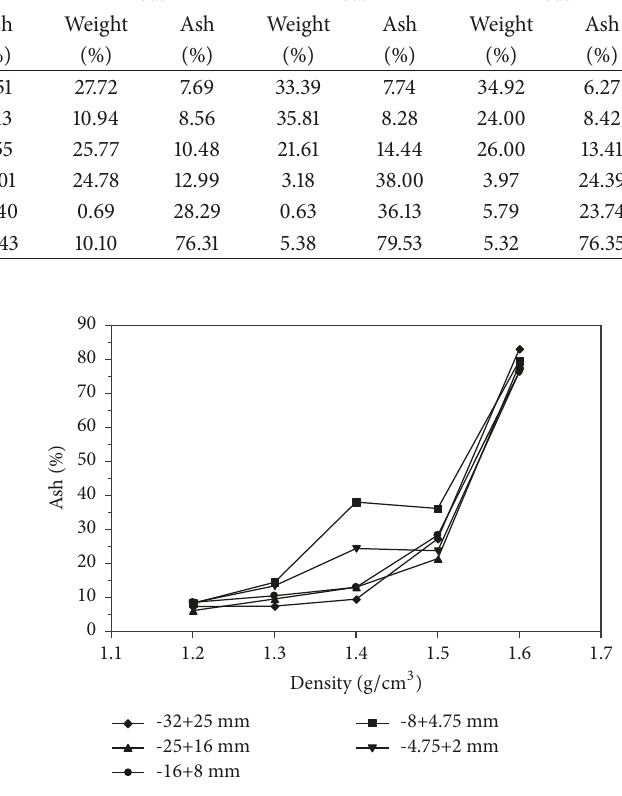
Figure 3: The ash contents of floated materials for all fractions at different specific gravities of